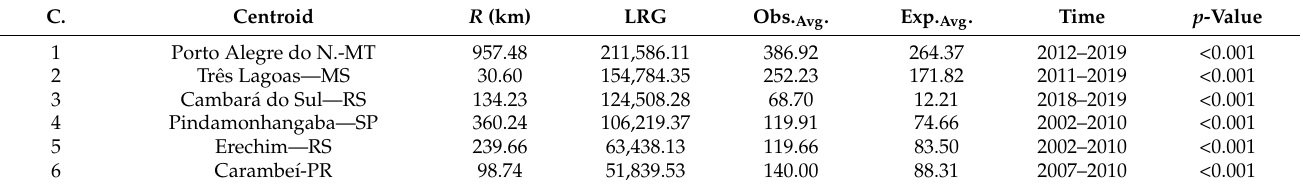
Table 1. Characterization of clusters of forest-based power plants in Brazil,